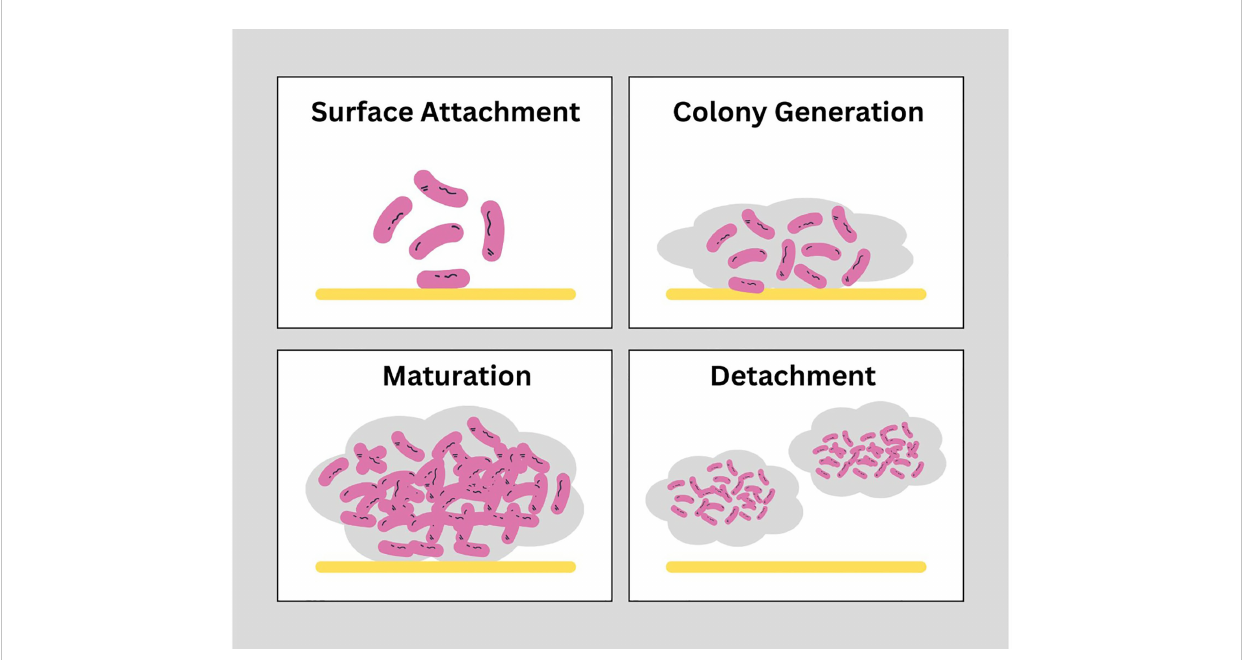
FIGURE 1 Stages of bio fi lm formation: Bio fi lms are structurally strong which are developed in 4 stages. Surface attachment: Involves reversible interaction of proteins of free-swimming planktonic bacterial cells with the surface of host cells or medical devices to achieve stability. Colony generation: Microcolonies within the matrix of bio fi lm replicate and double in number. Maturation: Complex structure of EPS matrix is formed with higher bacterial load within the structure. Detachment: The fi nal stage is dispersion of cells from matrix into outer environment.